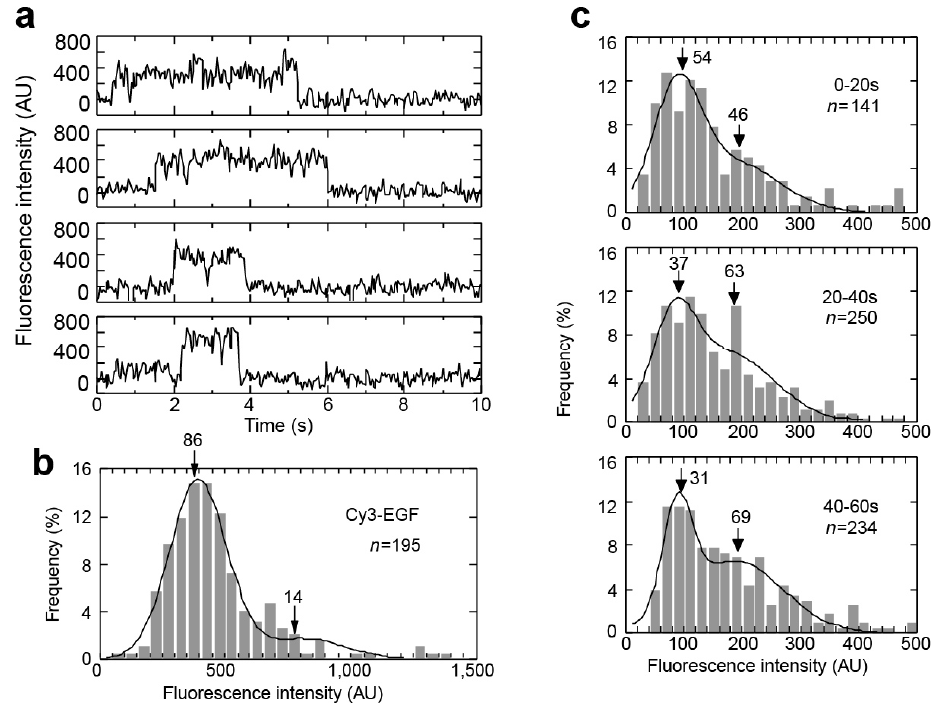
Figure 2. Single-molecule fluorescence data from Sako et al. (2000) [46], from fluorescent epidermal growth factor (EGF) bound to epidermal growth factor receptor (EGFR) in A431 cells: ( a ) Single-molecule fluorescence intensity traces; ( b ) Distribution of fluorescence intensity immediately after the addition of EGF; ( c ) Distribution of fluorescence intensity at time intervals following the addition of EGF.